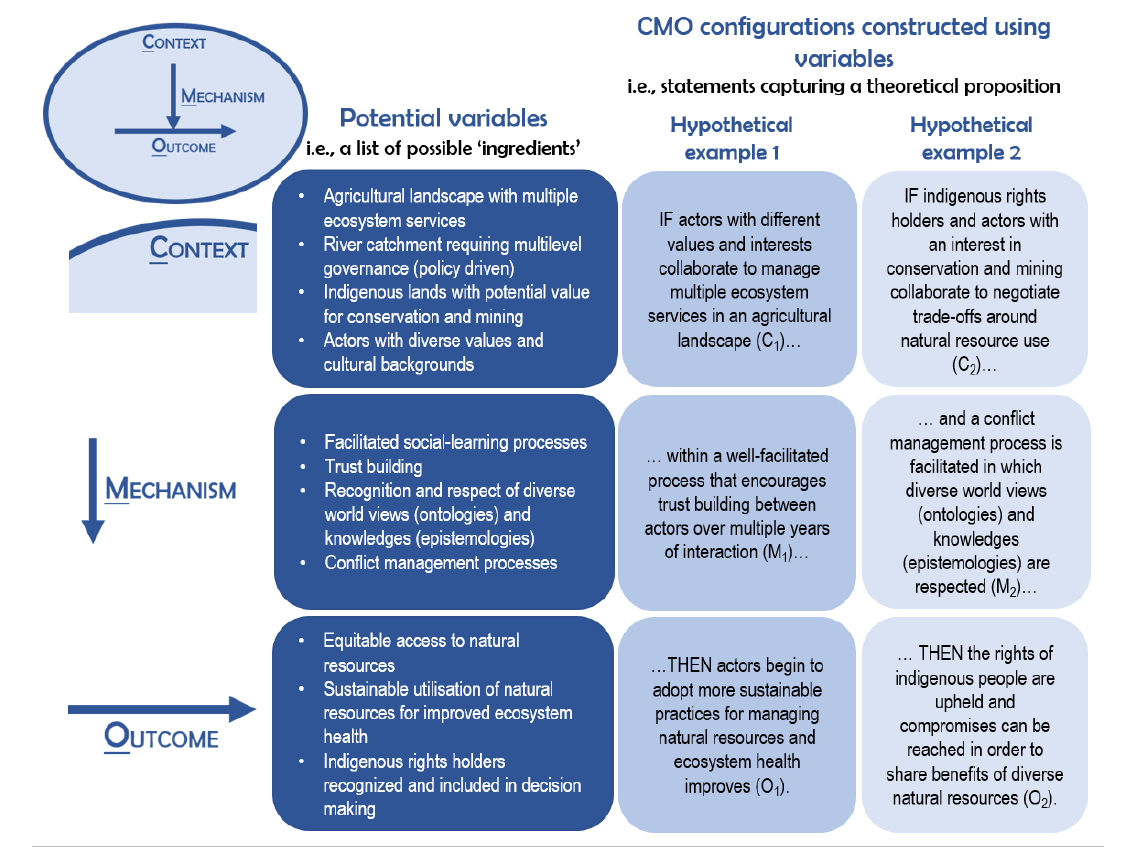
Fig. 1 . Example applications of realist evaluation methodology to understand multifaceted collaborations. The examples illustrate potential variables and context-mechanism-outcome (CMO) configurations. Note: For the sake of illustration, the examples of theoretical propositions given in the figure are somewhat simplistic. Things are obviously more complex, and it is precisely the objective of the method we propose to uncover this